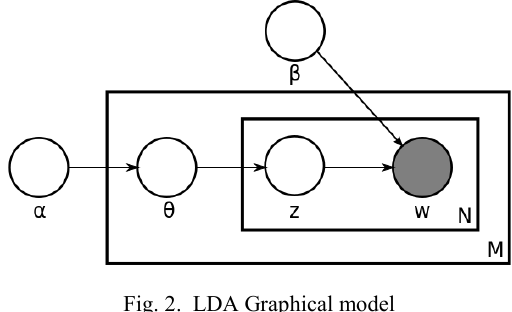
Fig. 2. LDA Graphical